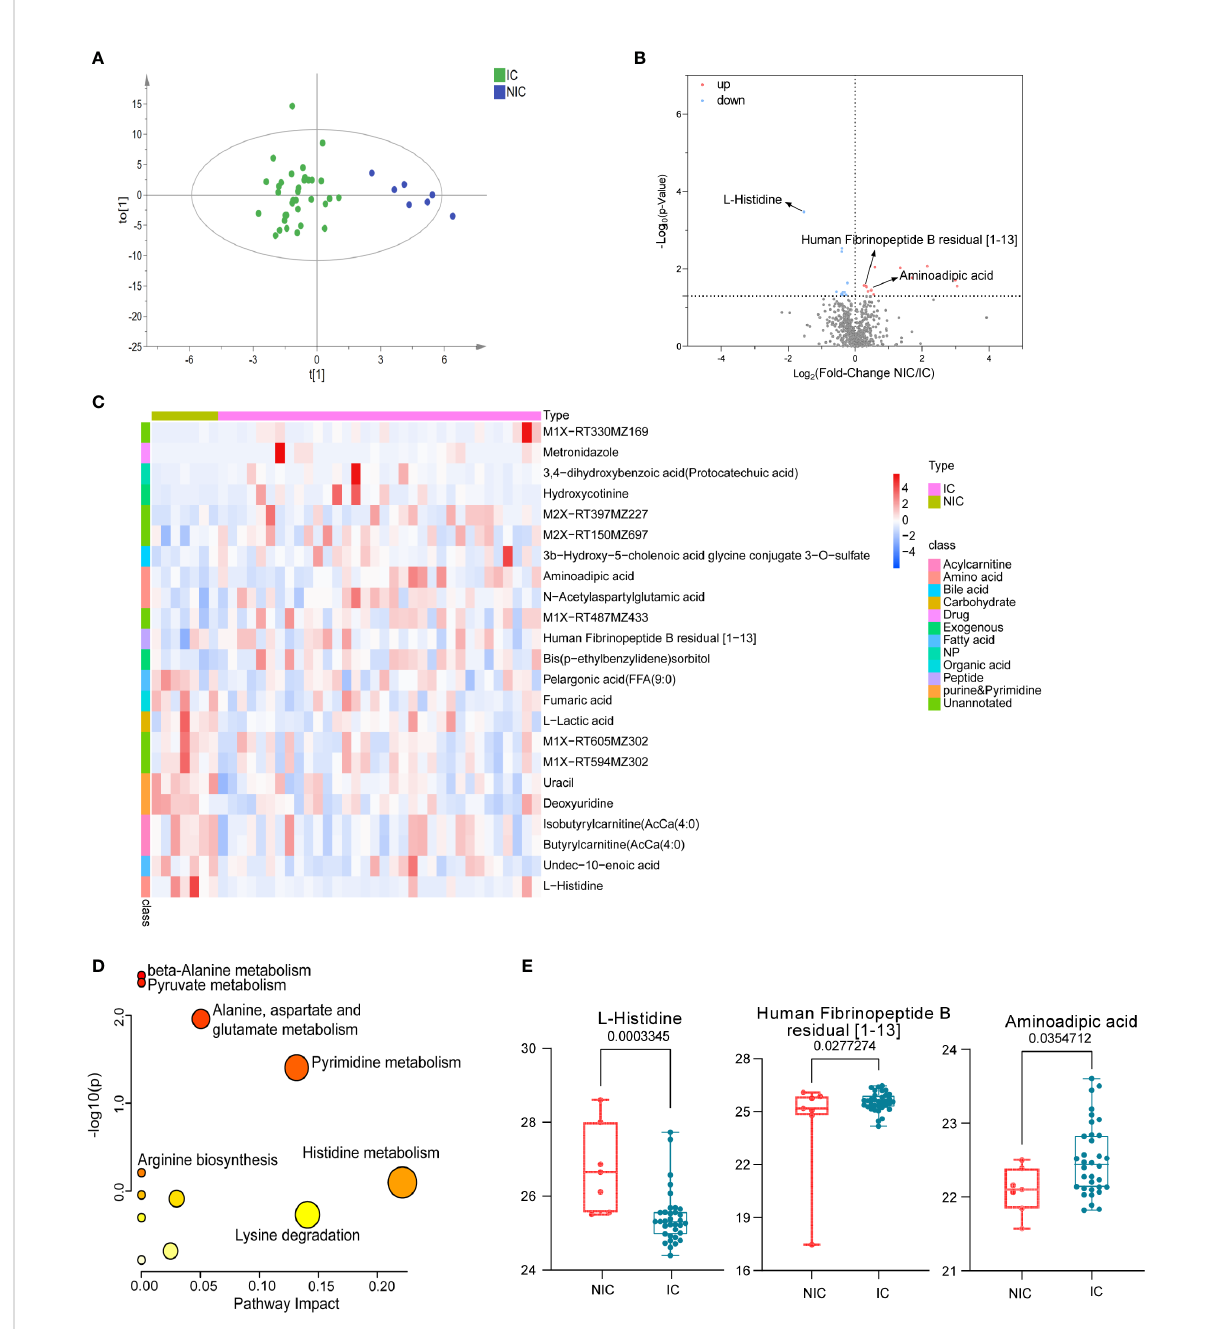
FIGURE 3 Polar metabolites in non-invasive (NIC) and invasive breast cancer (IC) group. OPLS-DA score plots of metabolites between non-invasive and invasive groups (A) . Volcano plots of metabolites. The red dots of the metabolites in the volcano plots indicated an increase, and the blue dots indicate a decrease in the invasive cancer group (B) . Relative concentration of metabolites in each sample in non-invasive and invasive group was visualized using a heat map (C) . Metabolic pathway enrichment analysis based on KEGG database was performed to determine differentially enriched pathways between non-invasive and invasive groups (D) . Relative concentration of L-Histidine, aminoadipic acid, and Human Fibrinopeptide B residual in the non-invasive and the invasive cancer group (E)